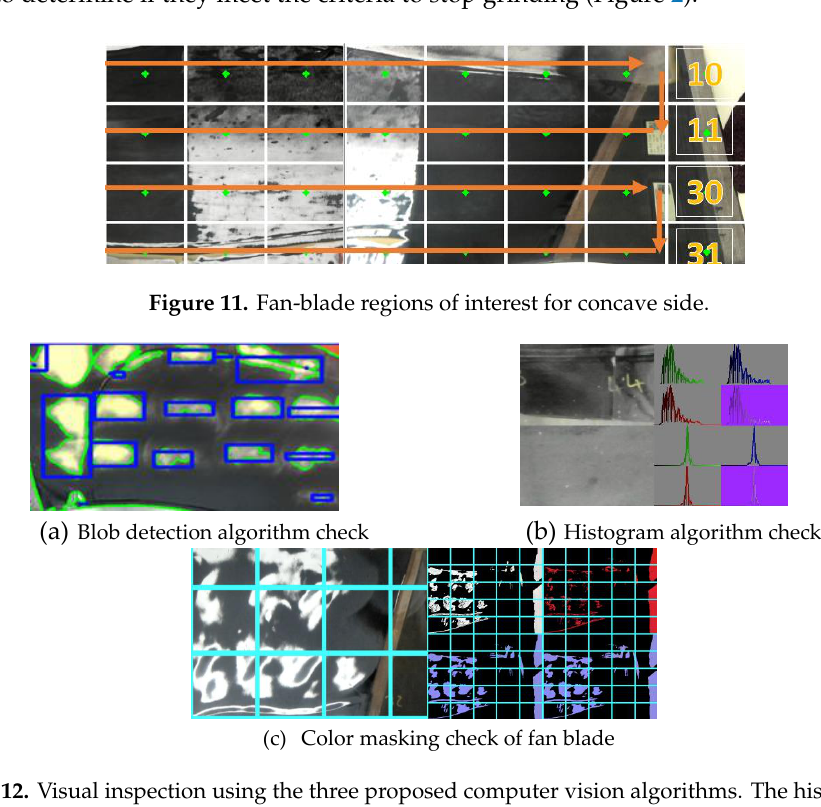
Figure 10. Robotic arm grinding head end-effector.